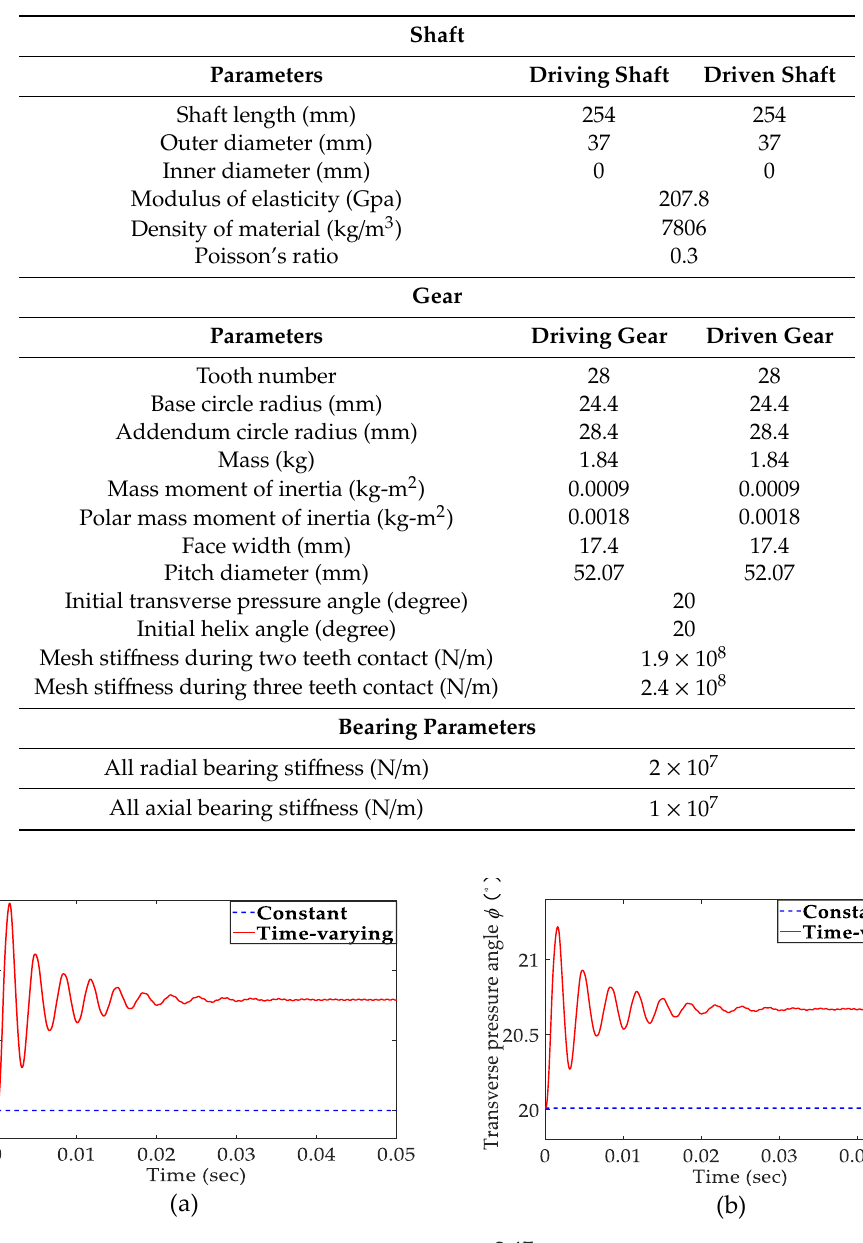
Table 4. Helical-geared rotor-bearing system parameters.